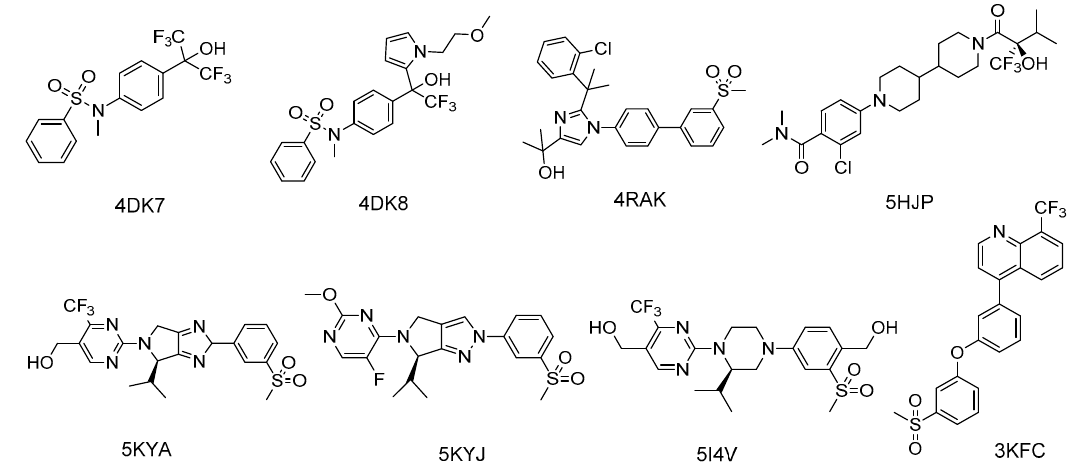
Figure 8. Structures of representative synthetic LXR β ligands.